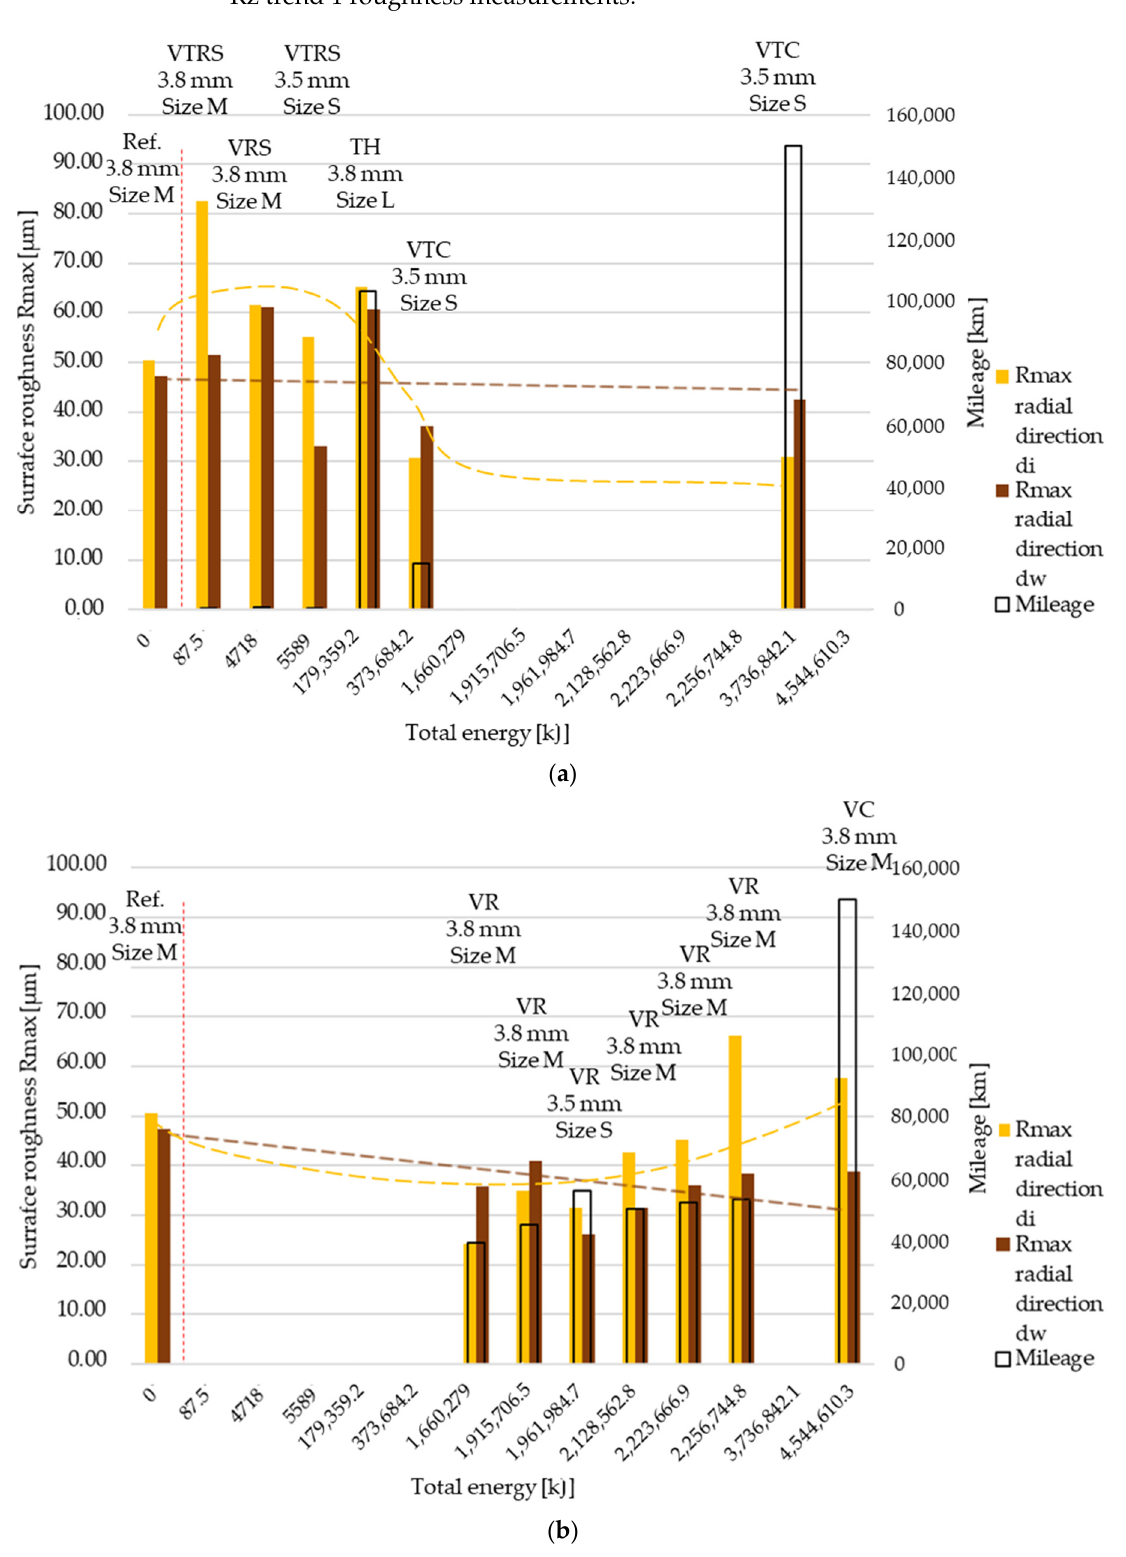
Figure 9. ( a ) Rmax surface roughness values, radial direction–trend 1: clutch killer tests. ( b ) Rmax surface roughness values, radial direction–trend 2: moderate tests.